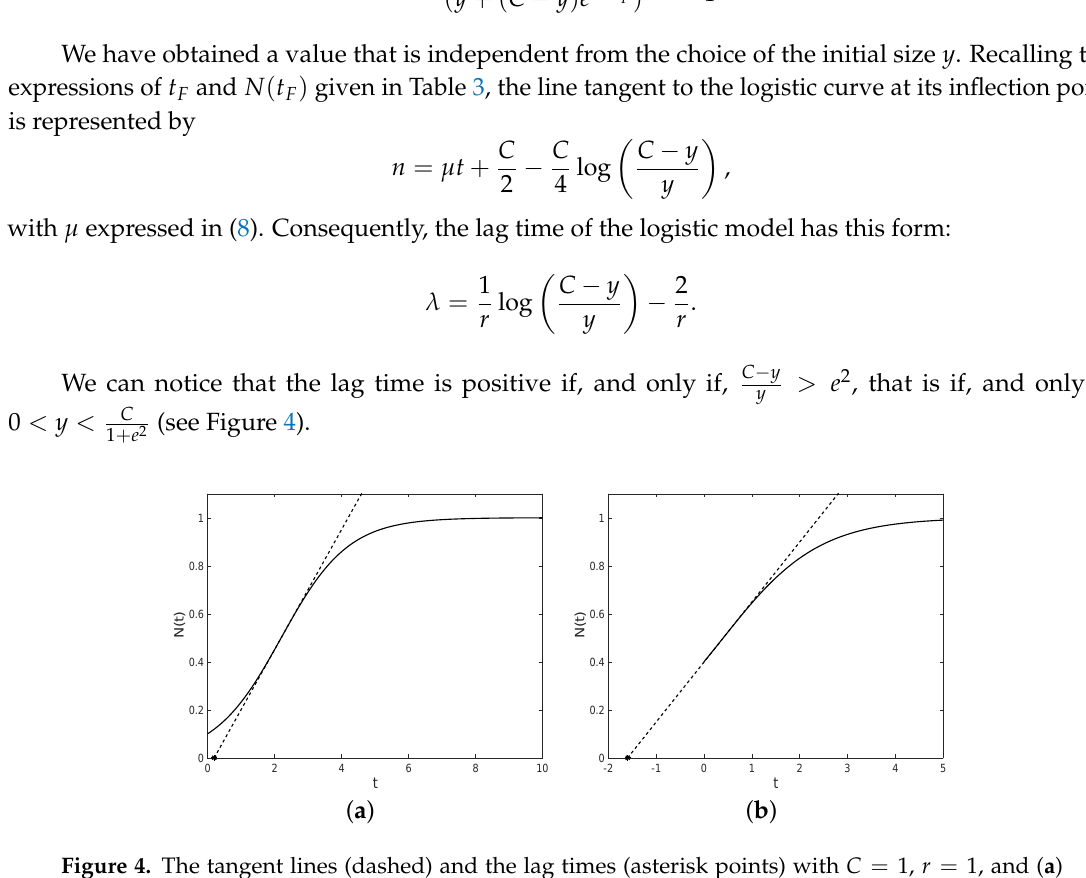
Figure 4. The tangent lines (dashed) and the lag times (asterisk points) with C = 1, r = 1, and ( a ) y = 0.1, ( b ) y = 0.4.